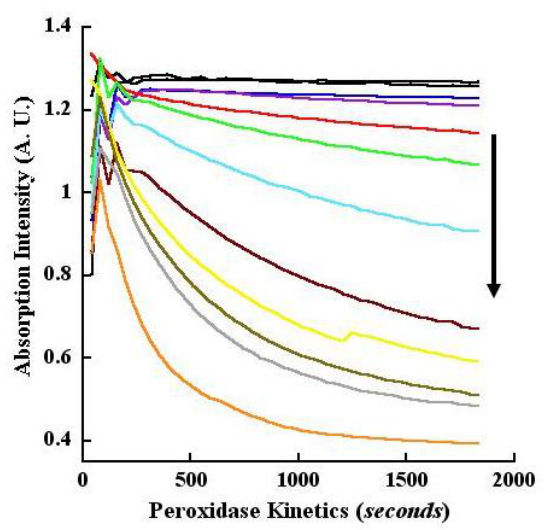
Figure 10A. Kinetics of peroxidase oxidation of CA monitored at 260 nm. Increasing concentrations of peroxidase-catalyzed oxidation of CA was monitored at 260 nm in kinetic mode (pH 4.5 buffer). Absorption changes over time and with different concentrations of the enzyme are represented by the various colored tracings with progressively decreasing intensities as indicated by the downward pointing arrow. The concentrations (ng/mL) of the peroxidase were: 1.0 (blue), 2.5 (purple), 5 (red), 10 (green), 20 (aqua), 40 (magenta), 60 (yellow), 80 (brown), 100 (gray) and 200 (orange). The top two black tracings that are nearly parallel to the abscissa represent control reactions O , without enzyme and without H 2 2